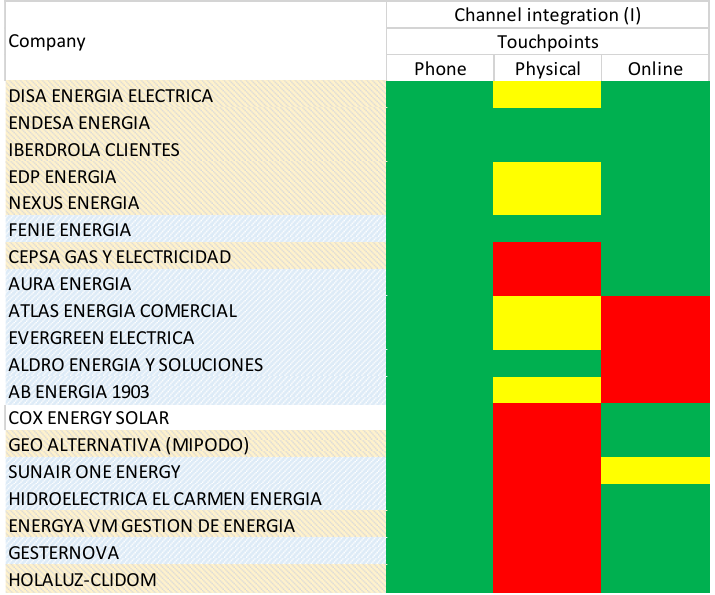
Figure A1. Summary of indicators of channel integration (touchpoints). Indicator coloring scheme: green = 1; red = 0; and yellow = 0.5. Company color scheme: yellow: Cluster 1; blue: Cluster 2; and white: mixed results.